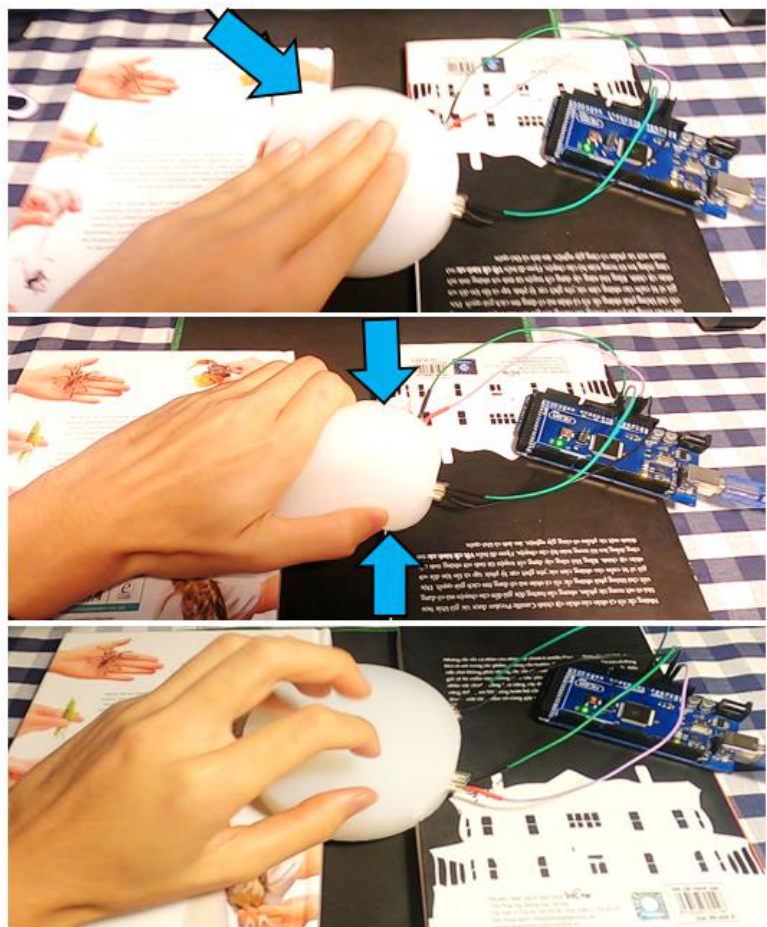
Figure 5. Applying different gestures from top to bottom; slapping with 4 fingers, squeezing with 5 fingers, and tickling with 4 fingers, respectively.